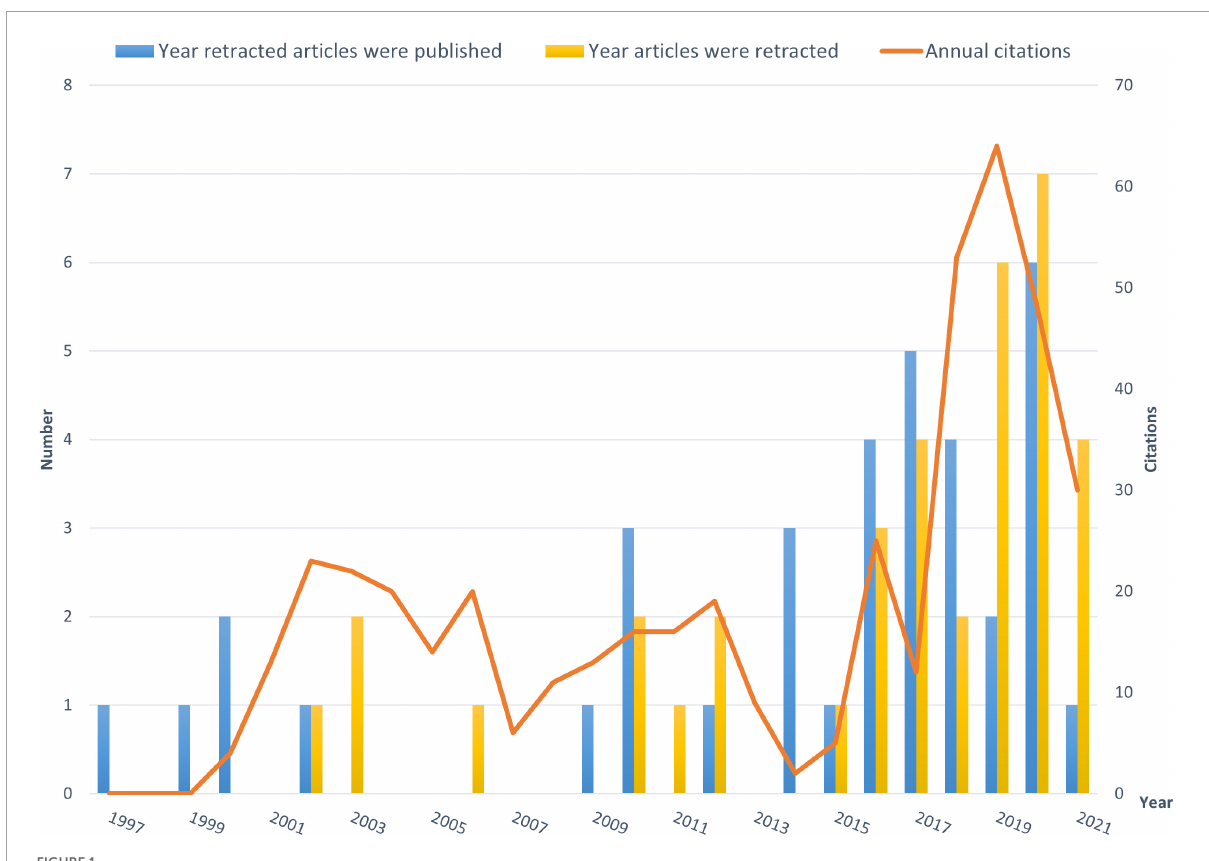
FIGURE1 Distribution of retracted publications on schizophrenia-related studies during 1997 and